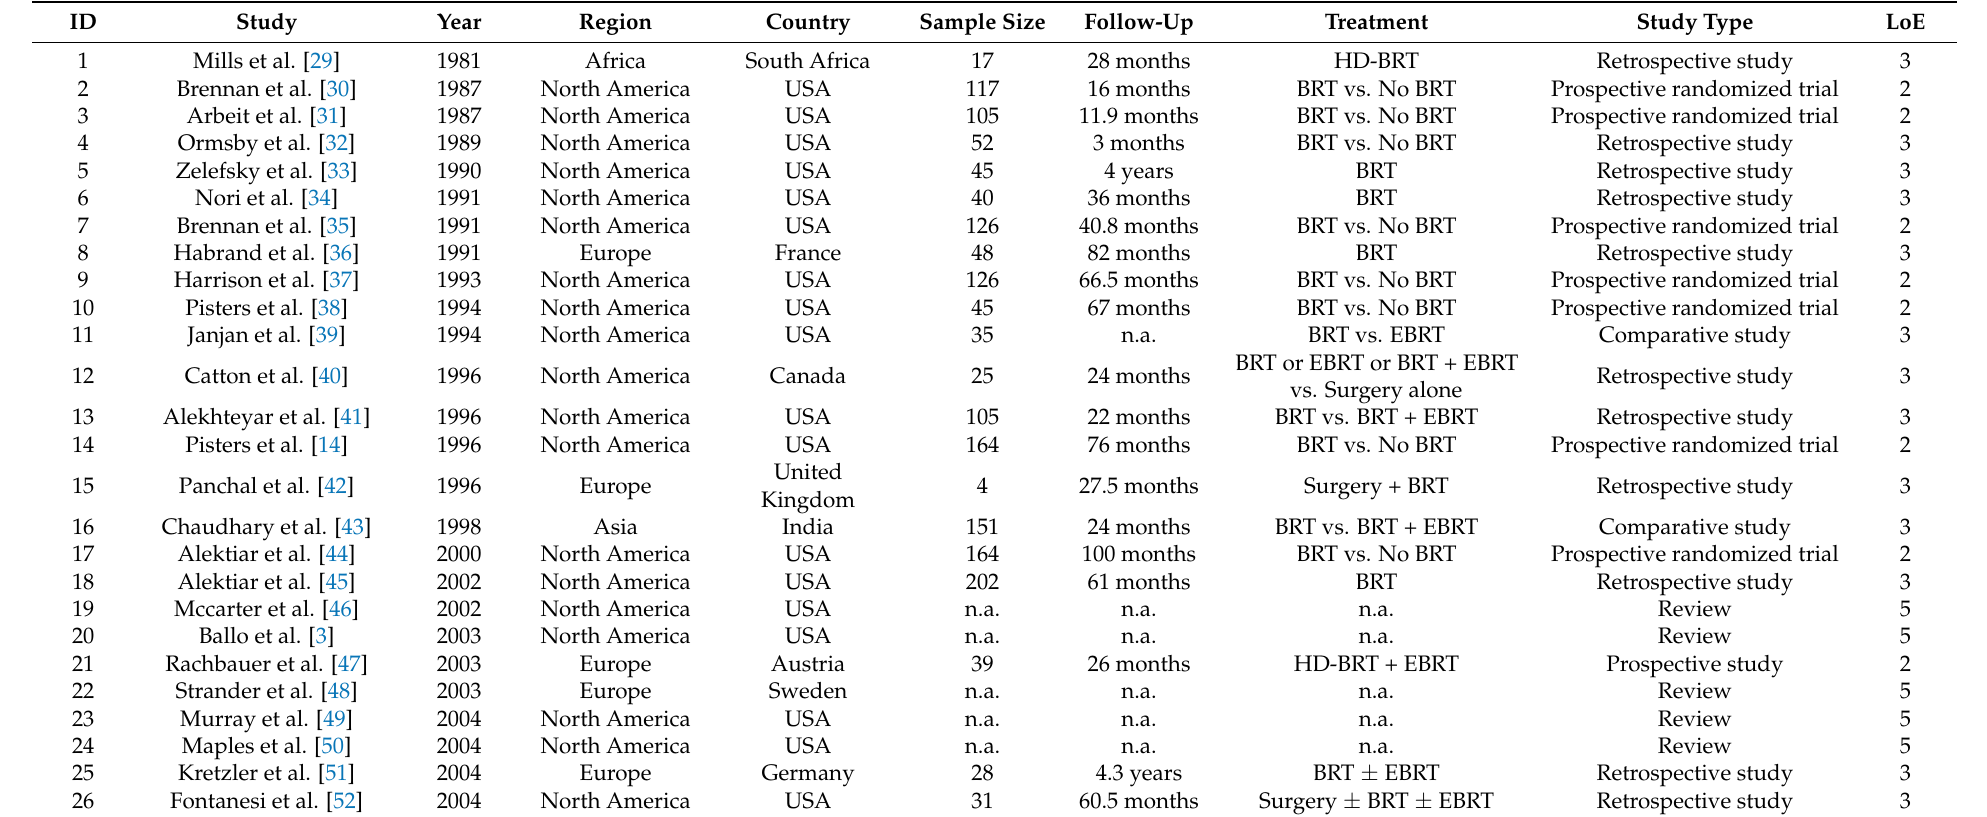
Table 1. Detailed study characteristics of included publications with level of evidence